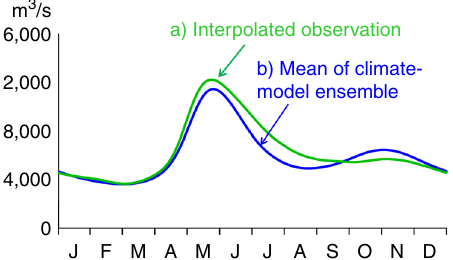
Fig. 5 Flow regime of the reference period when using observations or climate data. Daily average values of unregulated river fl ow from land to sea for the period 1981 – 2010, from the S-HYPE model, a using the national 4 km meteorological grid based on observations, and b for the mean of